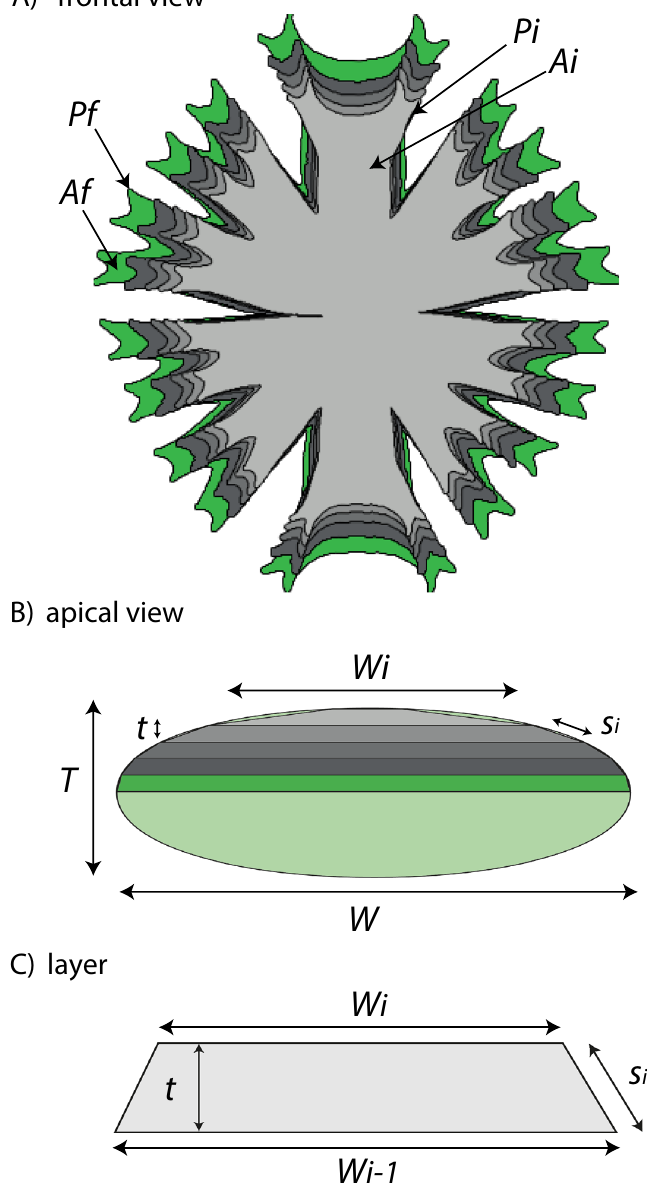
Figure 5. Illustration of a 3D mathematical model of cell created by stacking cross-sectional layers. ( A ) frontal view, green layer is the frontal view of the cell ( B ) apical view of stacked layers, green outline represents the apical view of the cell. Frontal view of the cell represents the biggest slice with the area ( A f ) and the perimeter ( P f ). Apical view of the cell defined maximal cell width ( W ) and the thickness ( T ). ( C ) Stacked layers were of equal thickness ( t ) and we measured width ( W i ) from which we calculated perimeter ( P i ), area ( A i ), and slant height ( s i ) , distance measured on lateral